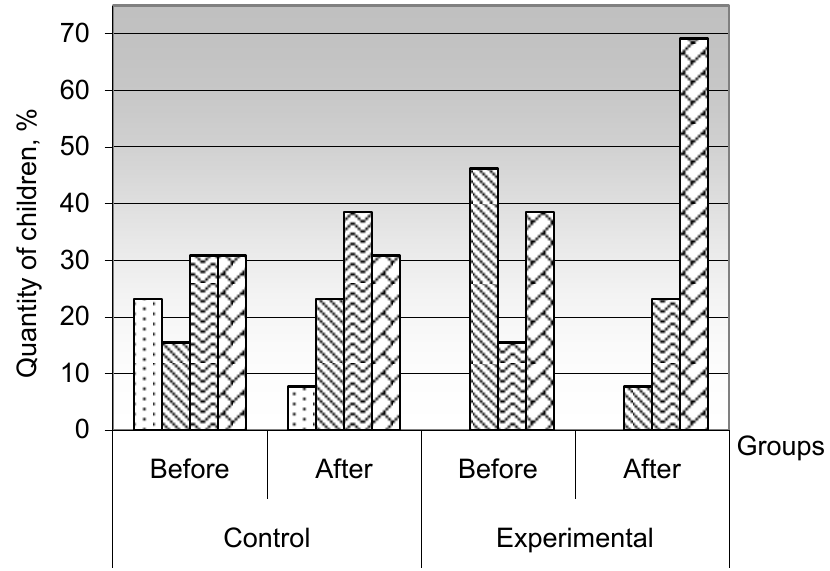
Before After Before After Control Experimental